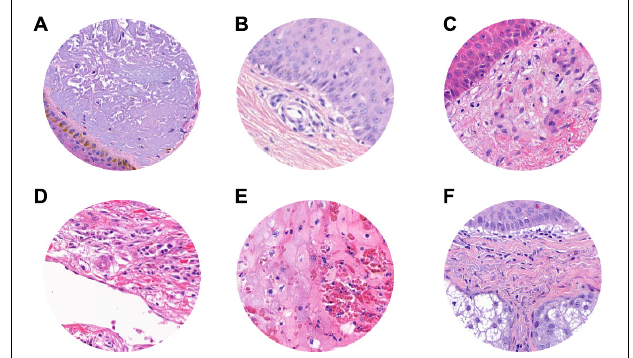
FIGURE 5 | ROI samples in which false-positive patches were identified. (A) Dermal solar elastosis (Grade 3). (A–C) Epidermal atrophy. (D) Abnormal dilated small-to-medium size vessels surrounded by normal dermal collagen. (D,E) Extravasated erythrocytes in the dermis or within adnexal epithelium. (F) Sebaceous adnexal structures and follicular epithelium.